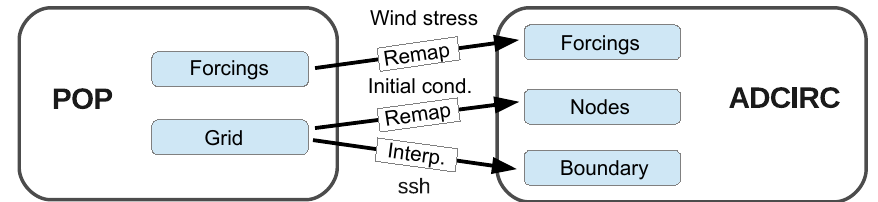
Figure 16. Schematic representation of the POP–ADCIRC one-way coupling for an embedded domain. The labeled arrows indicate the use of remapping channels. “Remap” stands for a conservative remapping between the structured POP grid and the unstructured ADCIRC grid, while “Interp.” indicates that the variables are interpolated.